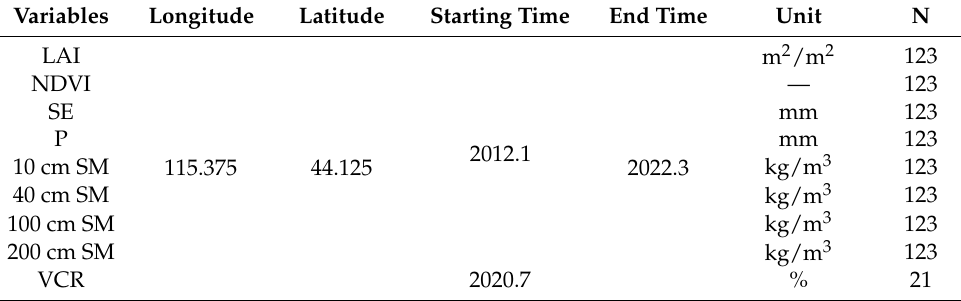
Table 1. Observed values of each